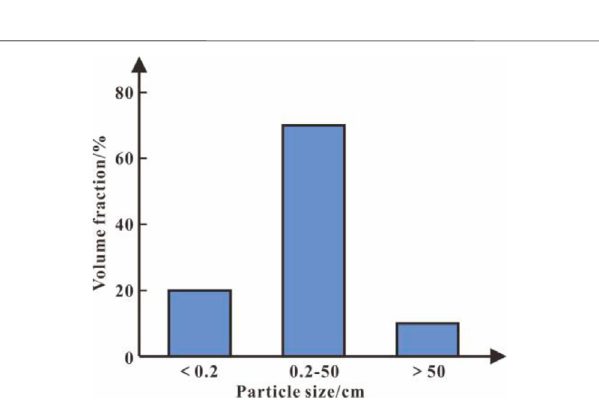
FIGURE 14 | Statistics of particle size composition of basalt landslide deposits in Southwest China.